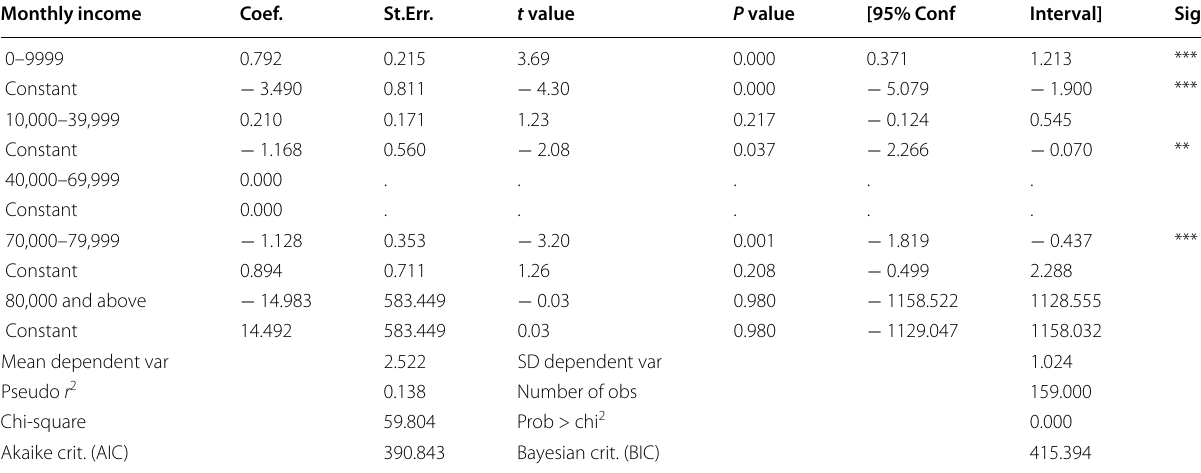
Table 8 Multinominal regression with compliance to physiotherapy